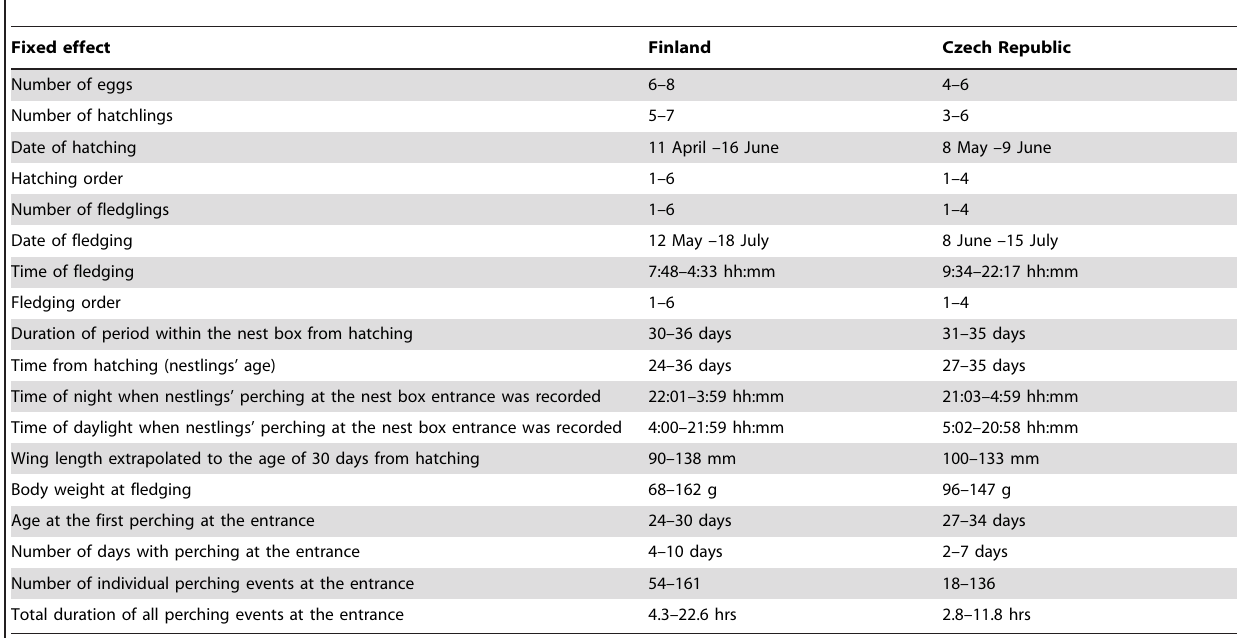
Table 1. Fixed effects used in the GLMMs (I, II) for the individual duration of nestlings’ perching at the nest box entrance during the night (I) and daylight (II).